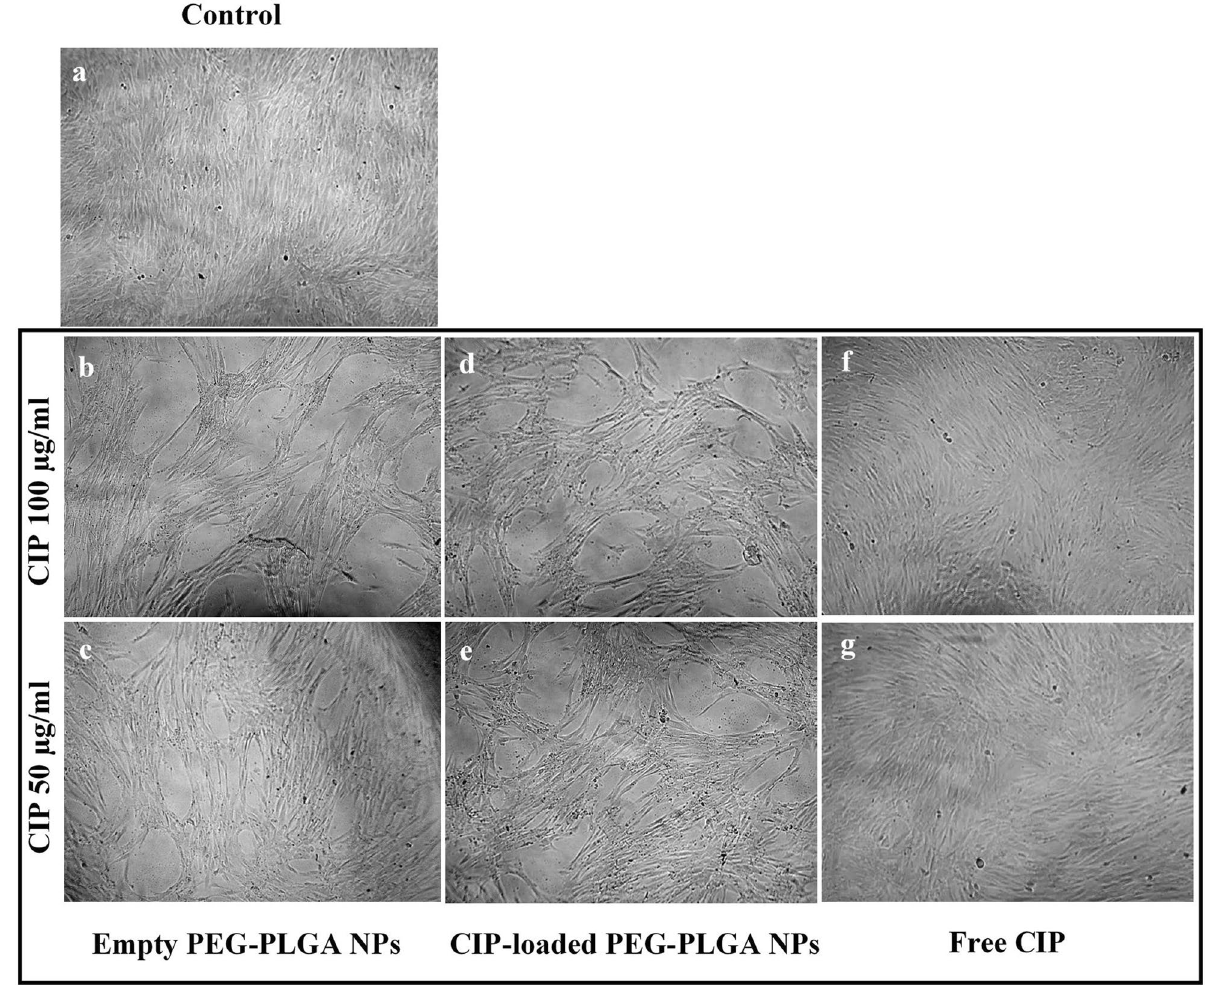
Figure 5. Stem cells from the apical papilla (SCAPs); ( A ) control (untreated cells) and after being treated with ( B–C ) empty PEG–PLGA nanoparticles, ( D–E ) CIP-loaded PEG–PLGA nanoparticles, and ( F–G ) free CIP for 24 h. The images were taken at 10X magnification using a Compact Cell Culture Microscope, CKX3